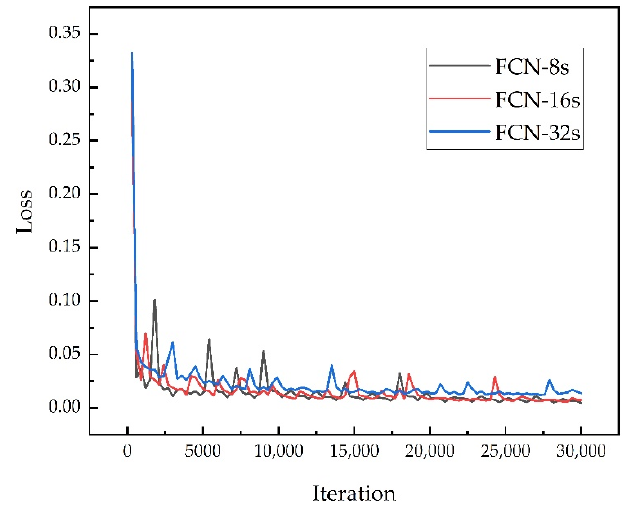
Figure 8. The cost function curve of the FCN-8s, FCN-16s, and FCN-32s.